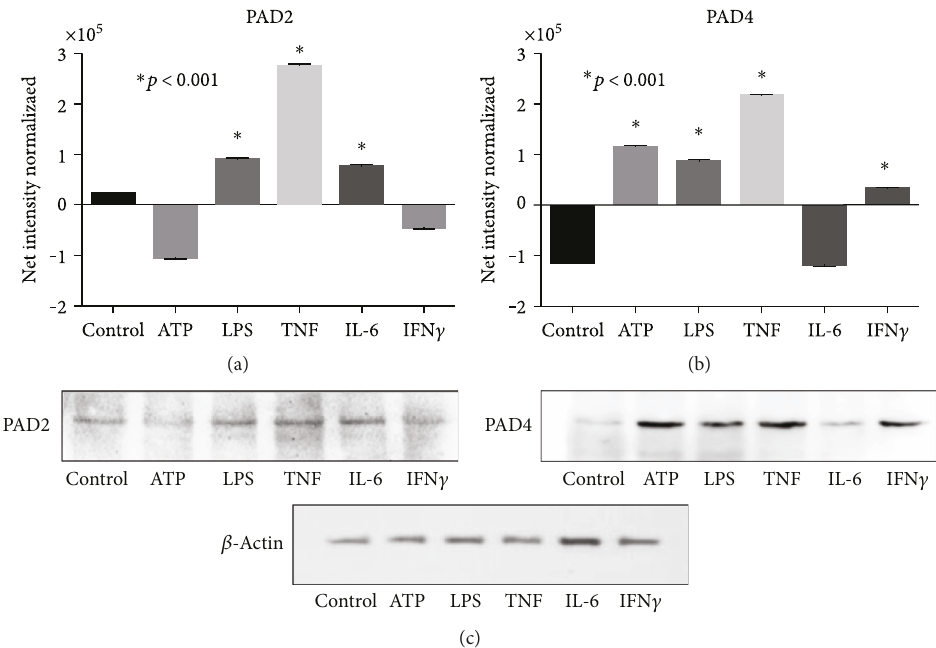
Figure 4: Di ff erent molecular triggers induce PAD enzyme expression, as assessed by Western blot analysis. (a) PAD2 enzyme and (b) PAD4 enzyme graphs showing relatively lower levels of PAD2 and PAD4 enzymes induced by molecular triggers. Graphs were normalized by β -actin housekeeping protein. (c) Western blot of PAD2, PAD4, and β -actin.